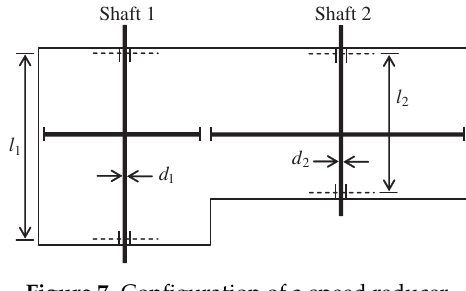
Figure 7. Configuration of a speed